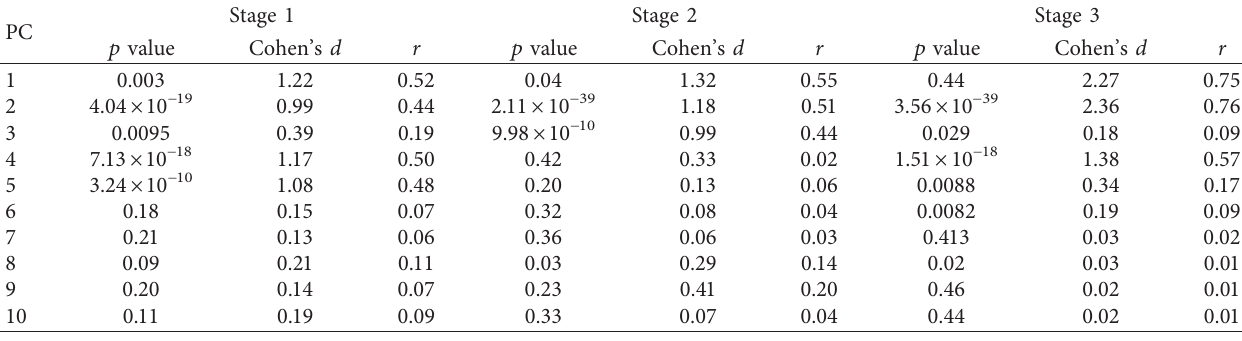
Table 4: Student’s t -test ( p values) and effect sizes (Cohen’s d and Pearson’s correlation coefficients ( r )) showing the relationship between the principal component scores of normal (PNT1a) and malignant (PC3)